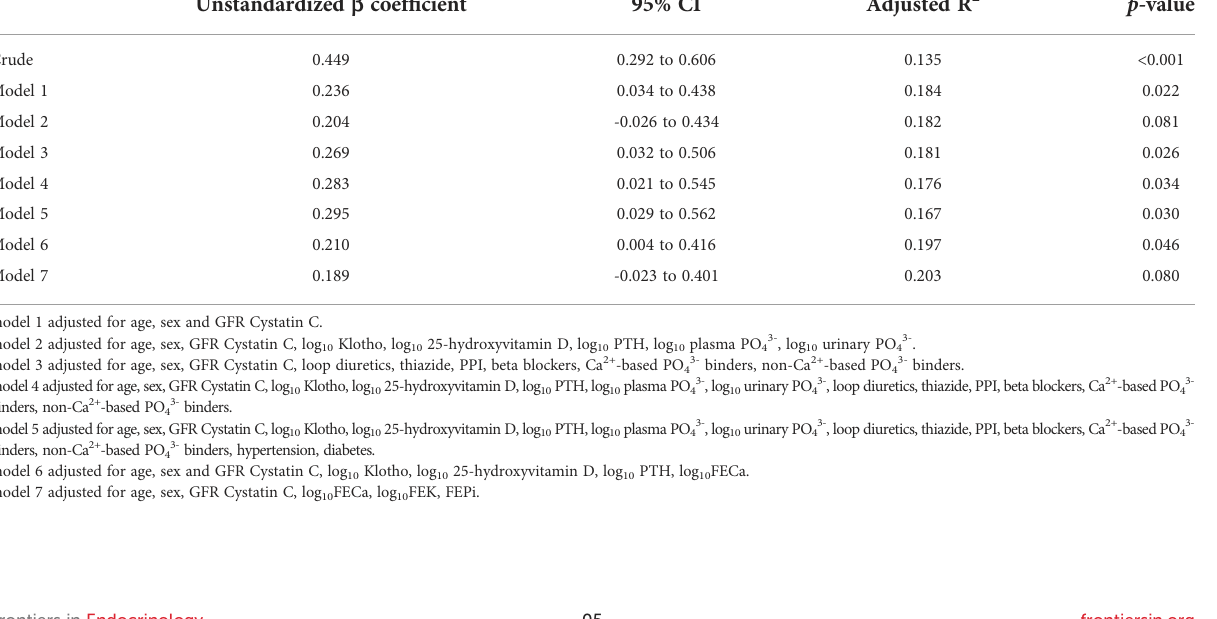
TABLE 2 Linear regression models exploring the association between FGF23 and FEMg.